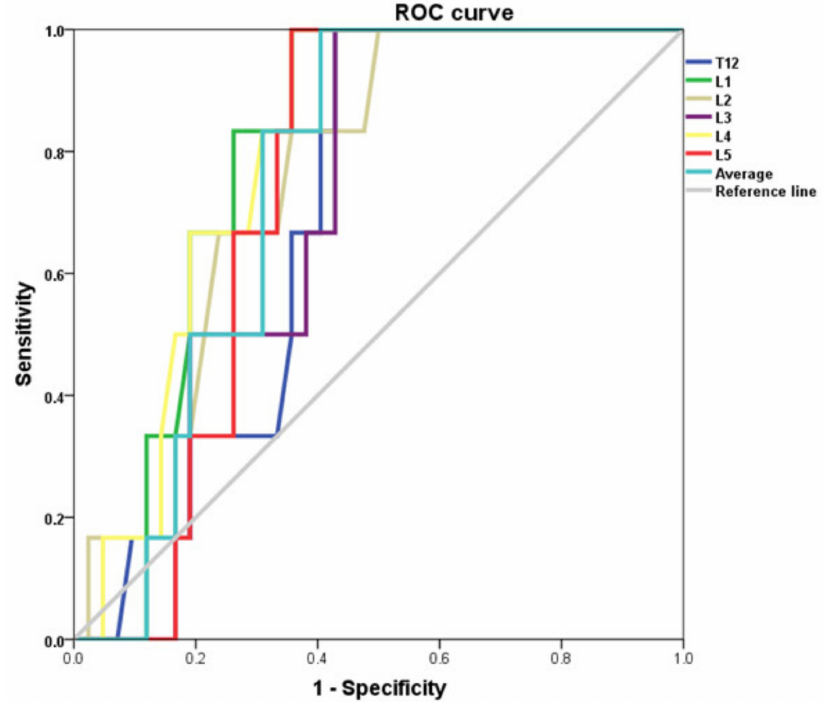
Figure 4. ROC curve for CT diagnosis of osteoporosis (DXA T-score ≤ −